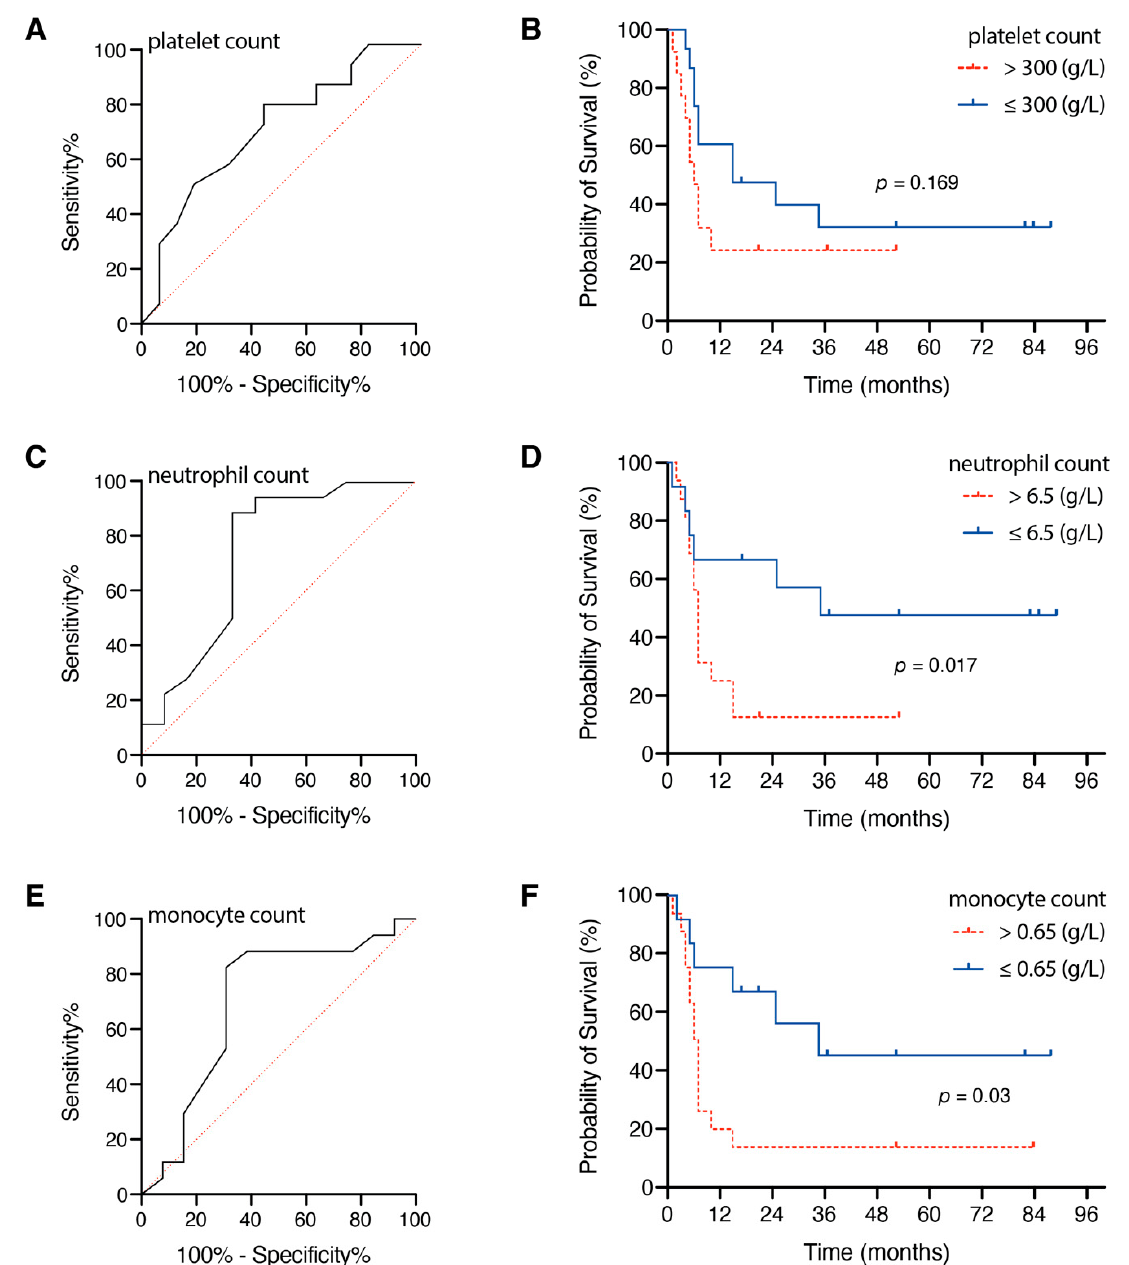
Figure 2. Receiver operating characteristic (ROC) curves ( A , C , E ) for preoperative blood cell parameters and Kaplan–Meier survival curves ( B , D , F ) stratified by preoperative blood cell